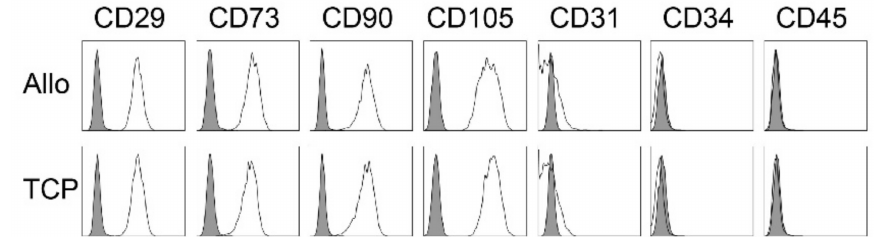
Figure 2. Representative flow cytometry analyses for MSC from cell-tissue composites (CTC) from allogenic (Allo) and synthetic (TCP) bone substitute material for one patient. Data are shown as a histogram overlay: isotype control (grey) and specific cell surface markers (white). Cells were labeled with antibodies against CD29, CD73, CD90, CD105, CD31, CD34 and CD45.